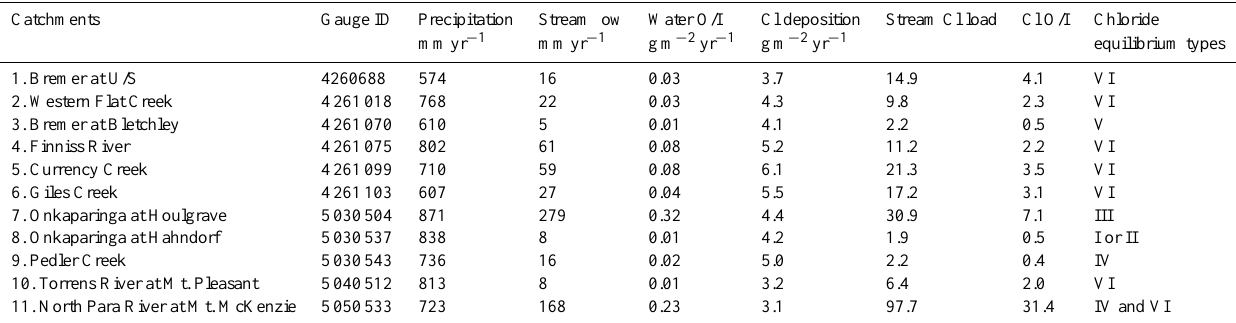
Table 3. Atmospheric input and streamflow output of water and chloride of the eleven catchments and their possible corresponding chloride equilibrium status (The precipitation and chloride deposition data were calculated from the long-term average distribution maps, while streamflow and its chloride load was calculated from the observation period listed in Table